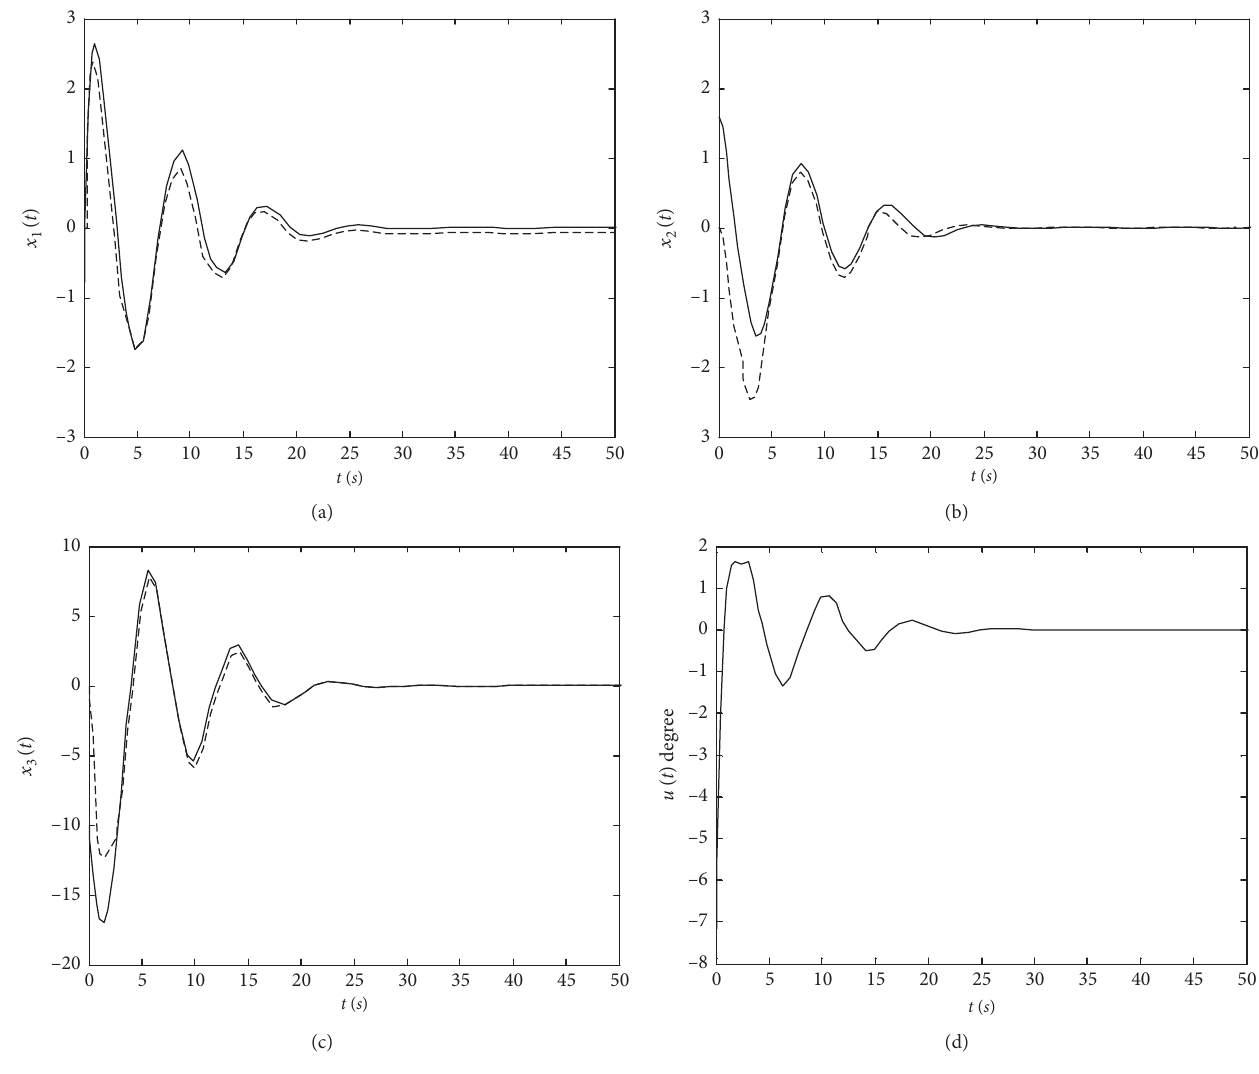
Figure 3: State responses x ( t ) and 􏽢 x ( t ) and control action u ( t )